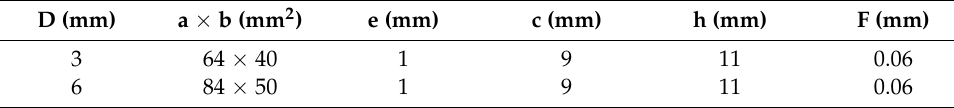
Table 1. Dimensions of the honeycomb sandwich.